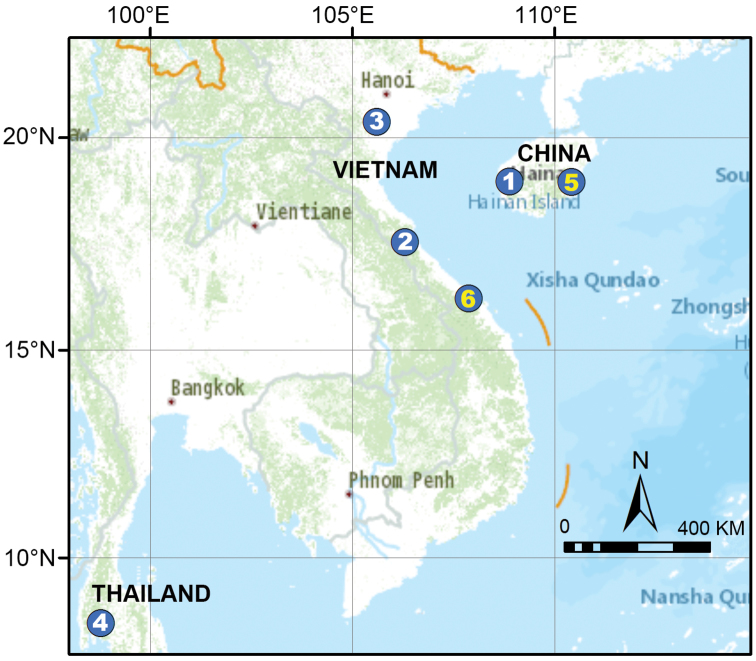
Distribution of Qiongocera and Relictocera species in China (Hainan), Vietnam, and Thailand. White numbers indicate new species and yellow numbers indicate previously known species. 1Qiongoceraluoxuan sp. nov. 2Relictocerawugen sp. nov. 3R.sigen sp. nov. 4R.qianzi sp. nov. 5Qiongocerahongjunensis6Relictoceraqiyi.